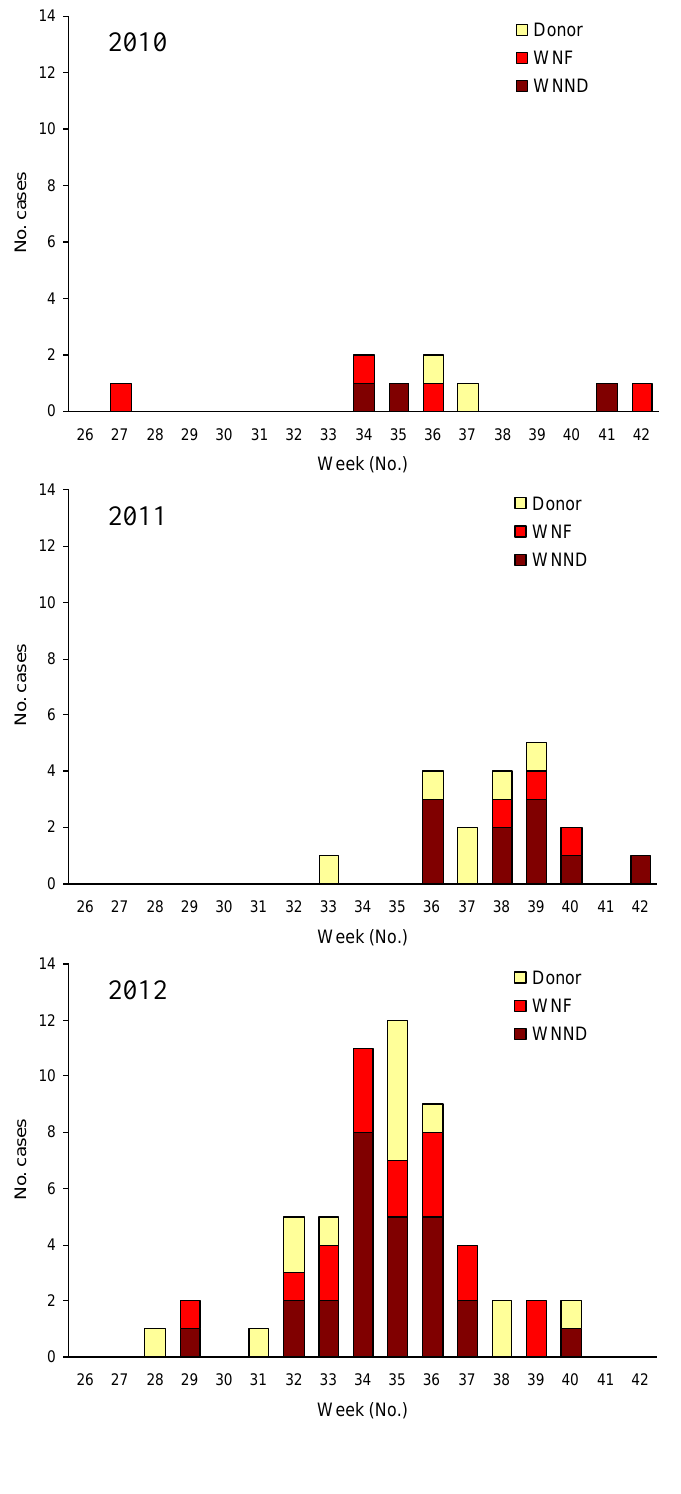
Figure 2. Cases of West Nile infection by week of symptom onset confirmed in North-eastern Italy, 2010–2012. WNND: cases of West Nile neuroinvasive disease; WNF: cases of West Nile fever; Donor: blood, tissue, and organ donors with confirmed WNV